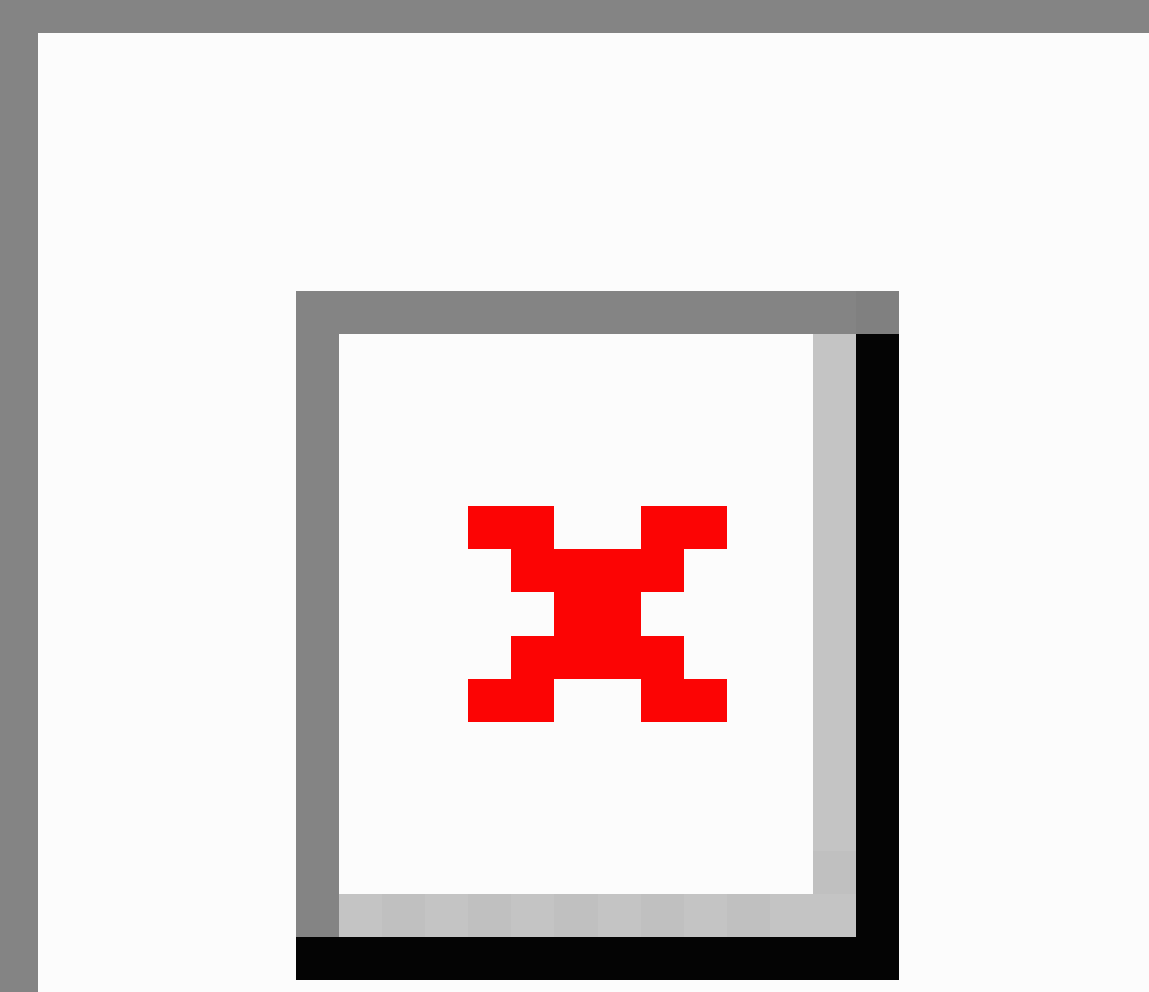
Figure 5. Mean Asthma Control Questionnaire score for the Internet and Usual care group as measured at 0, 3, 12, and 30 months of